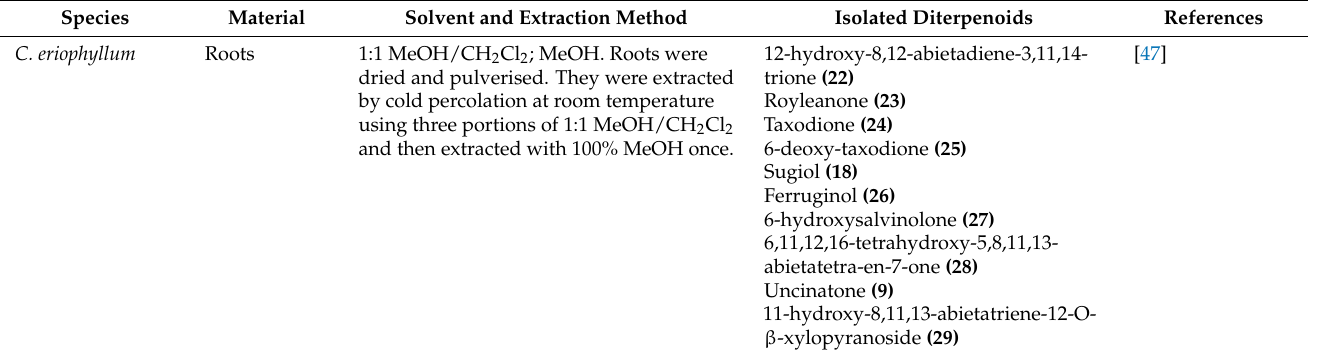
Table 3. The diterpenoid extraction method and C. eriophyllum plant material for diterpenoid isolation. Species Material Solvent and Extraction Method Isolated